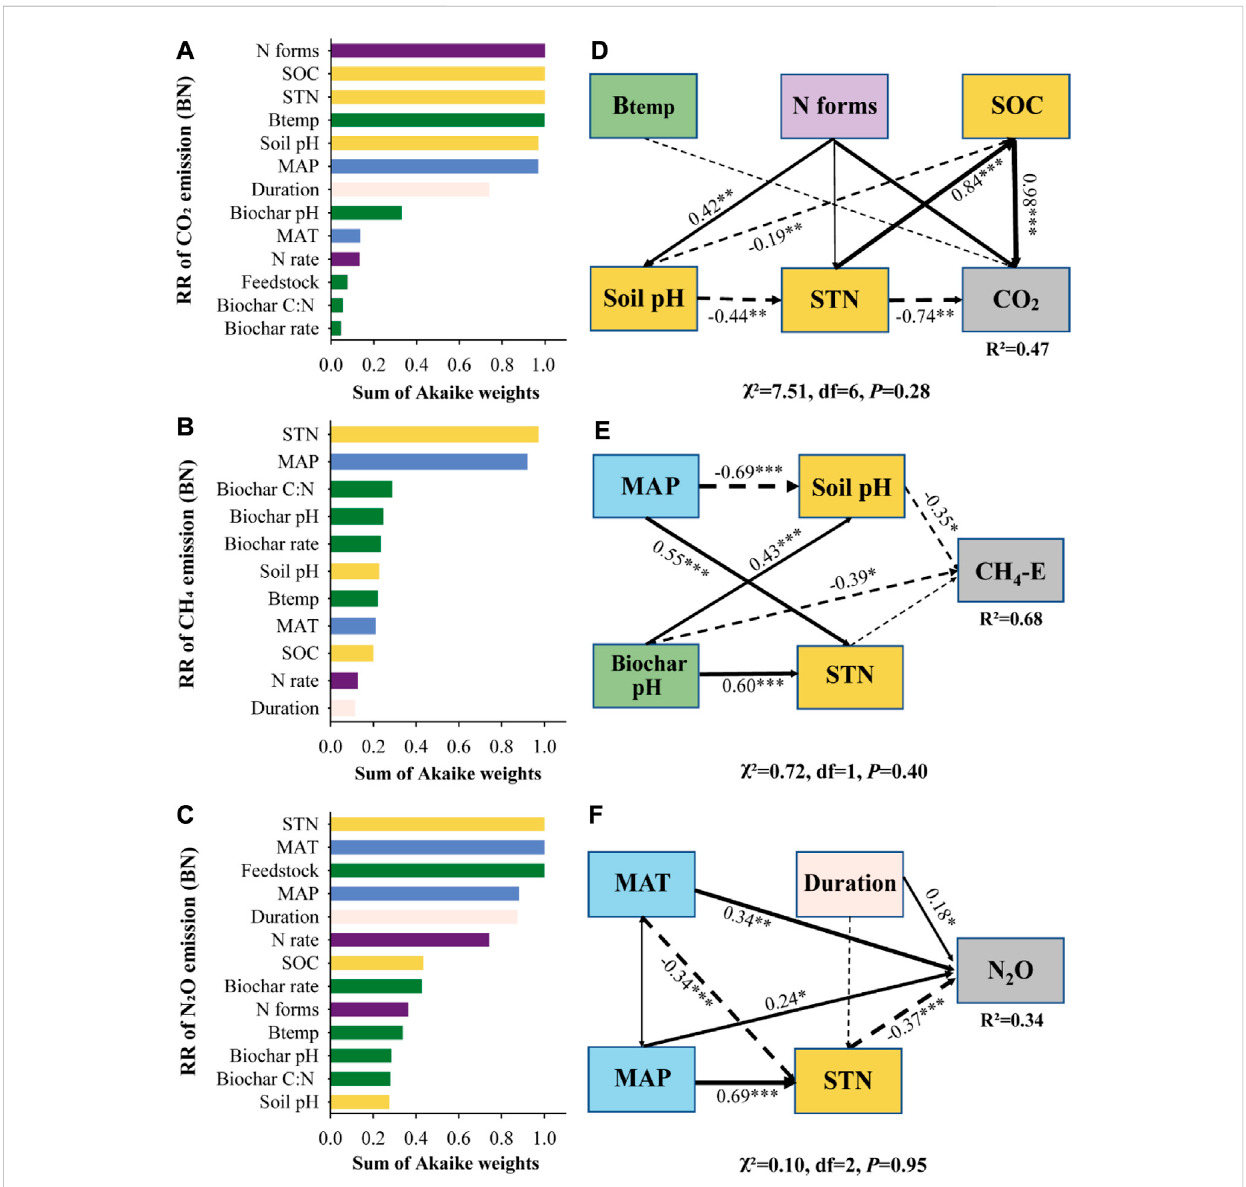
FIGURE 5 Model-averaged importance of the predictors of BN addition impacts on soil GHGs (A – C) . The structural equation model (SEM) examining the indirectanddirecteffectsofpredictorsonsoilGHGs (D – F) .MAP,meanannualprecipitation;MAT,meanannualtemperature;SOC:soilorganiccarbon;B temp: biochar pyrolysis